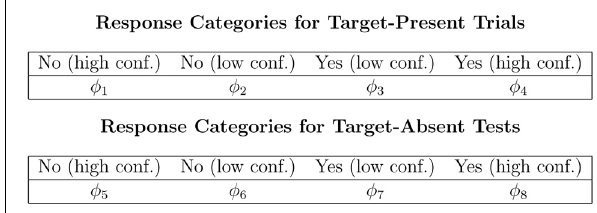
FIGURE 1 | Data categories and population proportions for the PD model.